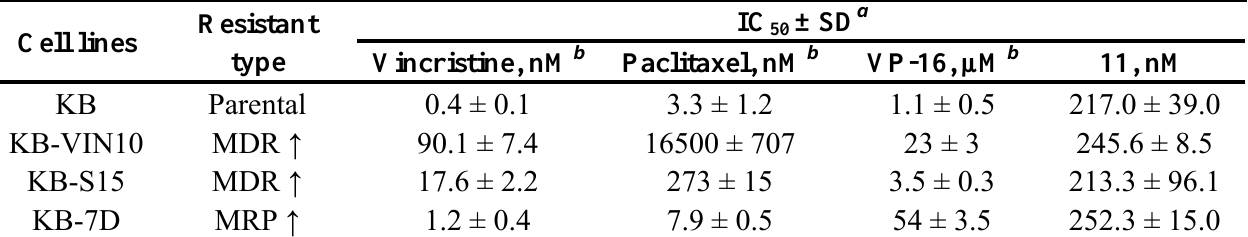
Table 2. Growth inhibition of compound 11 and reference compounds against drug- resistant cell